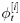
Probabilistic spatial learning using grid and boundary cells.(A) Self-motion (angular and linear displacement, Δϕ and λ) and boundary inputs (transformed via estimated heading, ϕt[i]) shift grid phase and activate boundary cells, respectively, forming associative maps (dashed ellipses) during learning. (B) Self-motion phase signal is integrated along each preferred direction of the grid cell (ϕd1, ϕd2, ϕd3) via plane wave oscillators, whose coincident activity leads to a hexagonal tessellating spatial grid in the absence of noise. (C) An example of plane wave oscillators produced by the interference between dendritic membrane oscillations, vd = cos(ωdt), and somatic membrane oscillations, vs = cos(ωst), producing an approximately sinusoidal rectified oscillation, Θ(vd + vs), where Θ denotes the Heaviside function [14]. (D) Distance tuning functions of short-range (left) and long-range (right) boundary cells (red line—maximum boundary detection distance without vision). (E) Firing rate map (right) of boundary cell with example tuning direction (E, left) and distance (D, shaded). See also S1 Fig and S1.1 Text.